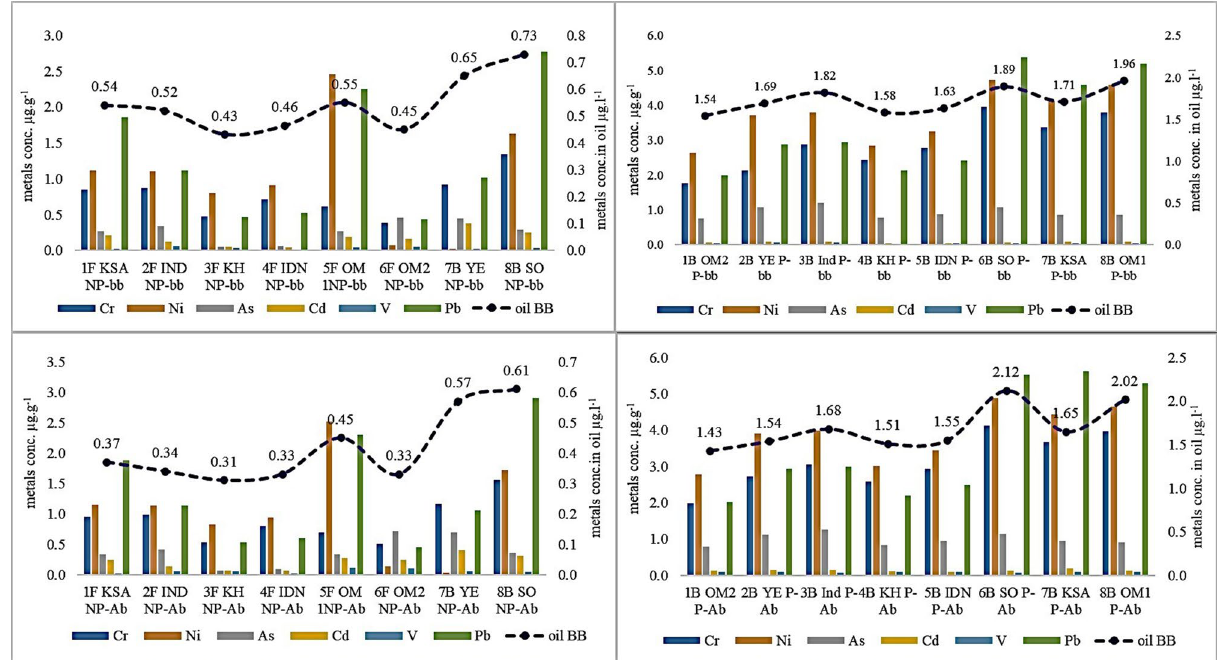
Figure 2. Country-wise, and metals-wise before and after smoldering in non-perfumed and perfumed incense. P perfumed, NP non-perfumed; IDN Indonesia, YE Yemen, SO Somalia, IND India, OM1 Oman-Dhofar,